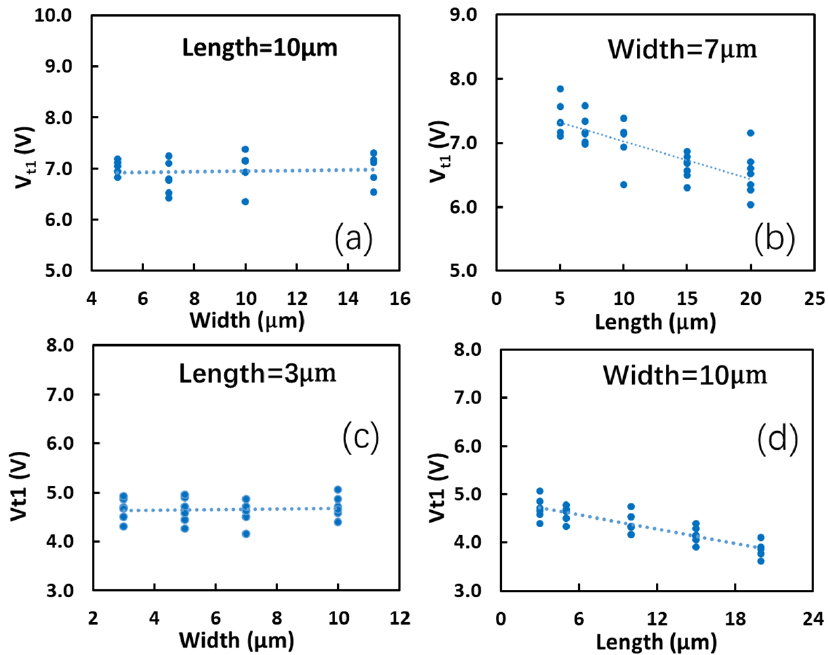
Figure 15. Statistical results for impacts of graphene ribbon dimensions on ESD V t1 in tests: ( a ) V t1 ~ W at a fixed L is almost flat under TLP; ( b ) V t1 ~ L at a given W shows a monotonous trend under TLP; ( c ) V t1 ~ W at a fixed L is almost flat under VFTLP; and ( d ) V t1 ~ L for a given W shows a monotonous trend under